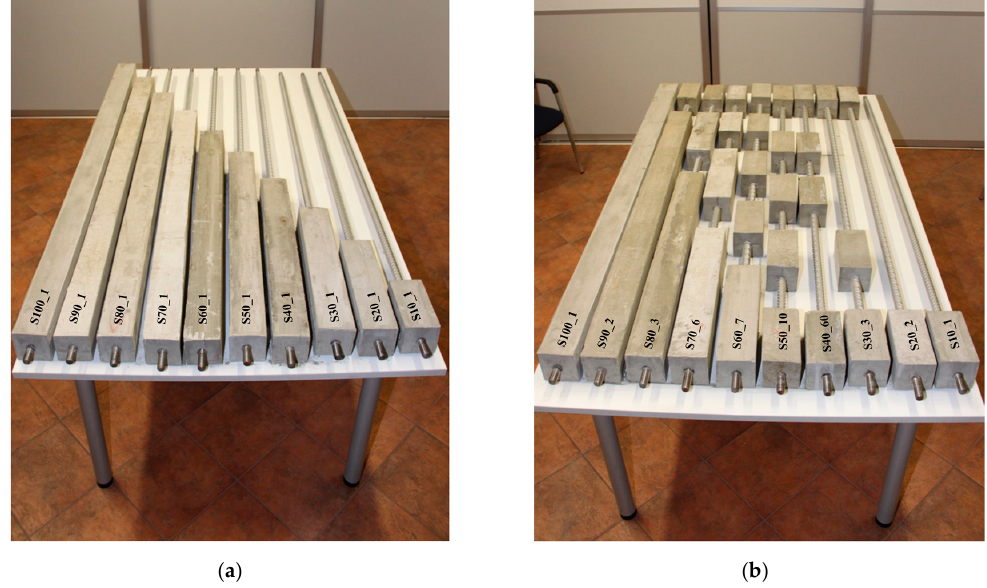
Figure 5. Rock bolt laboratory models: ( a ) Group I and ( b ) Group II.